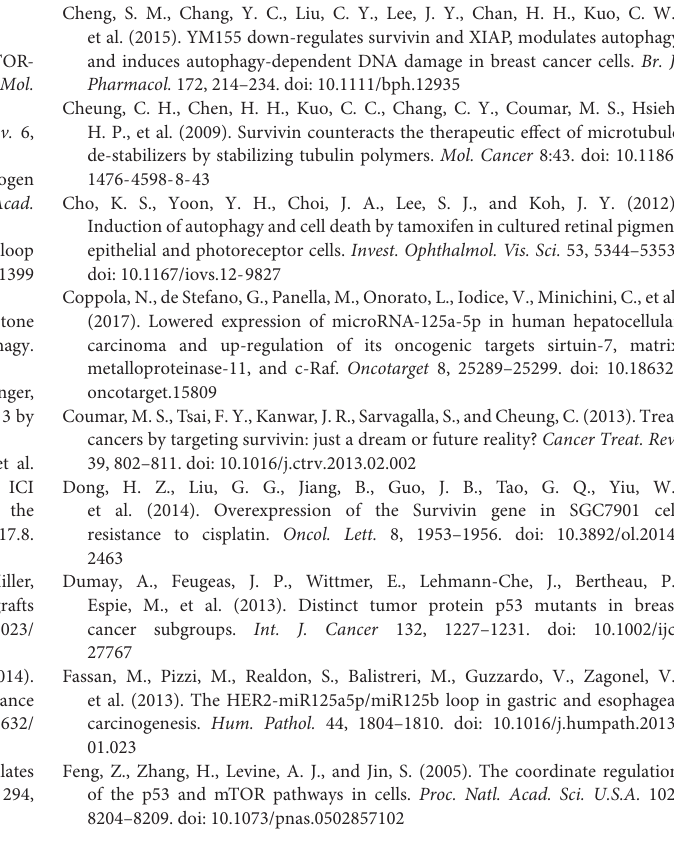
FIGURE S1 | Molecular characteristics of human breast MCF7, MCF7-TamC3, and ZR-75-1 cancer cells. (A,B) Expression of ER- α and caspase-3 in different breast cancer cells was determined by the Western blot analysis. FIGURE S2 | mTOR regulates the expression of survivin in breast cancer cells. MCF7, MCF7-TamC3, and ZR-75-1 cells were treated with the mTOR inhibitor, rapamycin, for 48 h and expression of various proteins was determined by the Western blot analysis. FIGURE S3 | HDAC2 regulates p53 and Sp1 expression in ER + breast cancer cells. (A) Results of the protein–protein interaction (PPI) networks analysis generated by the web-based software STRING version 10.0 (http://string-db.org/) showing possible regulations of survivin ( BIRC5 ) expression via p53 ( TP53 ) and Sp1 ( SP1 )-dependent mechanisms. Minimum required interaction score was set to 0.700 (high confidence) for the analysis. (B) MCF7 cells were transfected with scramble siRNA, HDAC2 siRNA, or HDAC2 siRNA together with the p53 inhibitor, pifithrin- α , for 24 h. Expression of survivin was determined by the Western blot analysis. FIGURE S4 | HDAC5 positively modulates Sp1 expression in ER + breast cancer cells. (A) The Sp1/miR-125a-5p interaction was predicted using miRNA target prediction software TargetScan (http://www.targetscan.org/vert_71/) and PicTar (http://pictar.mdc-berlin.de/). (B) MCF7-TamC3 and ZR-75-1 cells were transfected with either scramble or HDAC5 siRNA for 24 h and expression of Sp1 was determined by Western